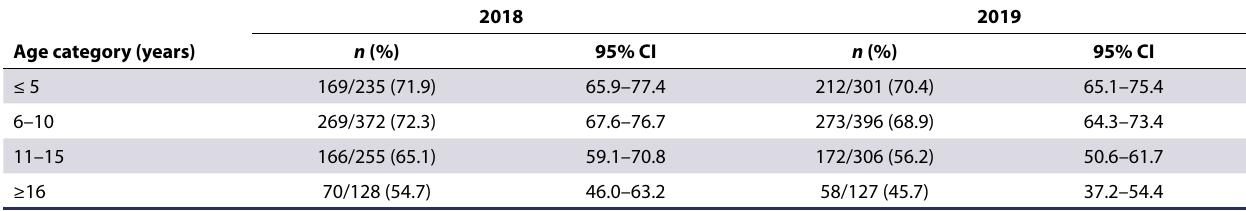
Table V: Summary of the proportion and percentage of Thoroughbred mares by age category tested, in the South African stud health scheme in 2018 and 2019, that produced a foal for identification Age category (years)